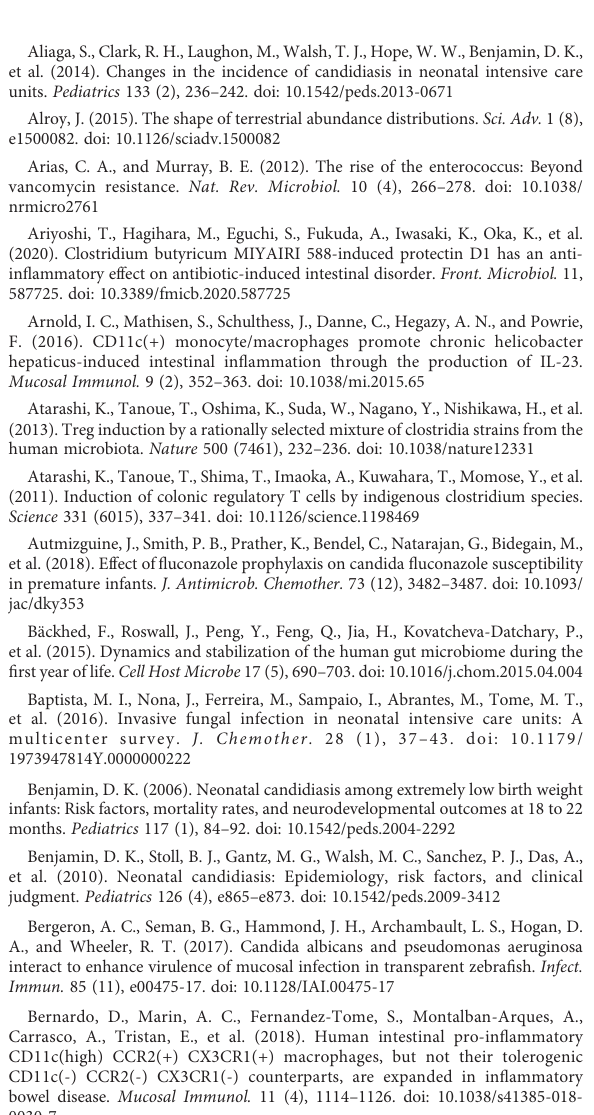
statistical differences in the three indexes. (D) Principal component analysis (PCA): color matching of each sample in groups. The fraction of diversity captured by the coordinate is given as a percentage. Relative proportions of sequences read at the genus (E) levels assigned to different bacteria. The microbiome abundance was less than 0.5% in all samples, and the unannotated microbiomes were all merged into Others. Comparison of relative abundance of bacteria at genus (F) levels. The results are mean ± SEM, and the P values of the differences between groups were tested by the Mann-WhitneyUtest.*P<0.05vsControl,#P<0.05vsControl,+P<0.05vs Fungal. (G) A GraPhlAn was used to examine the overall microbiota composition at the phylum-to-genus level of all